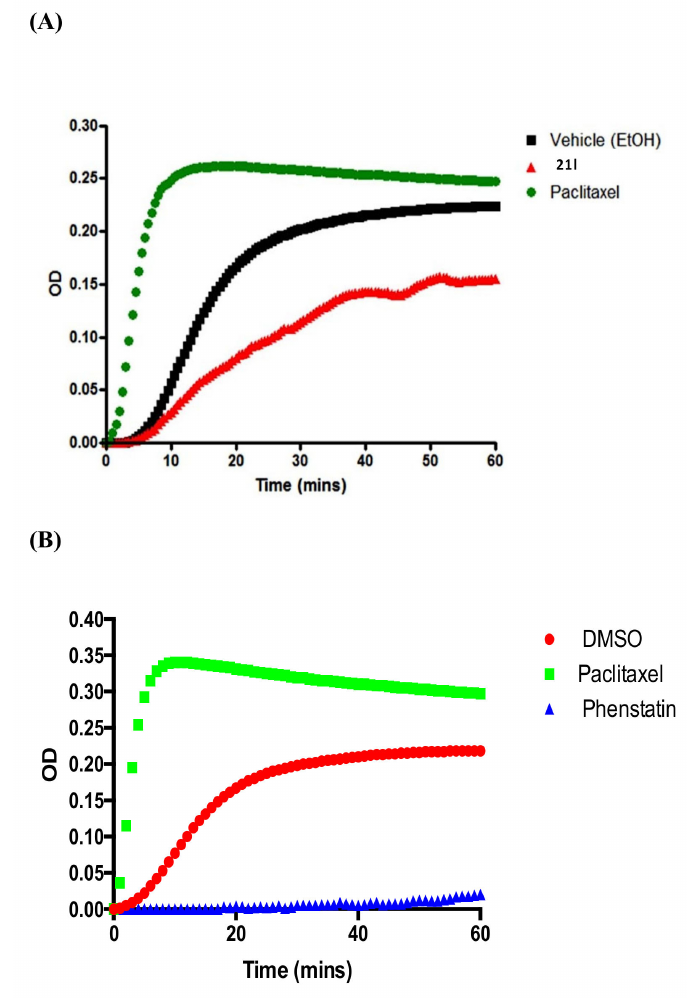
Figure 10. Effect of compound 21l on tubulin polymerisation in vitro. ( A ) Tubulin polymerisation assay for compound 21l at 10 µ M. ( B ) Paclitaxel (10 µ M) and phenstatin ( 7a ) (10 µ M) were used